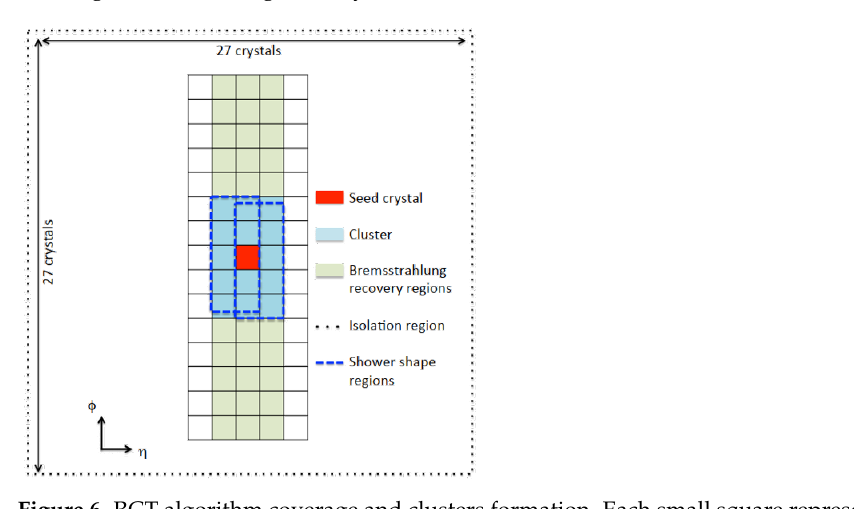
Figure 6. RCT algorithm coverage and clusters formation. Each small square represents one ECAL crystal. The seed represents the crystal with highest energy deposition by